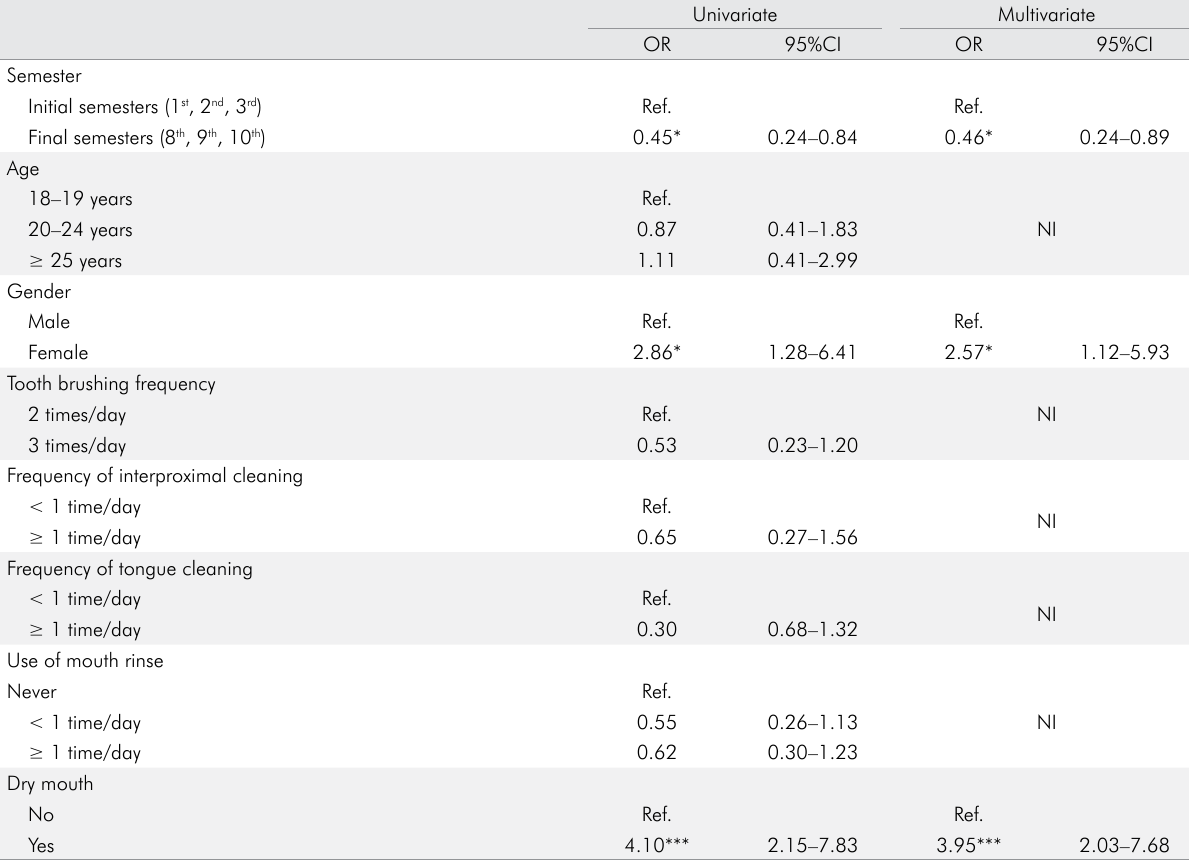
Table 2. Uni- and multivariable logistic regression models of the association between demographic and behavioral variables with self-reported